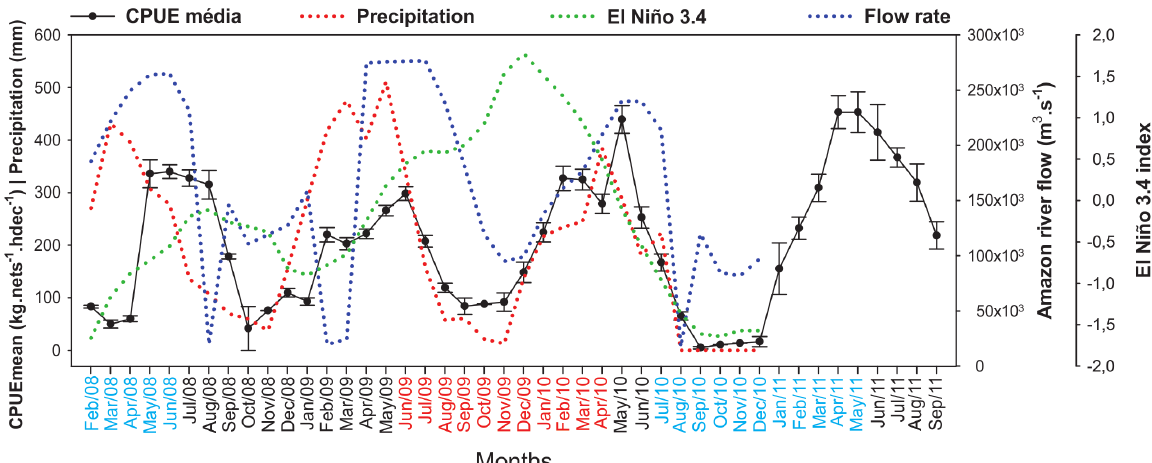
Figure 4. Variation 1 CPUE average per month B. vaillantii , El Nino index variation 3.4 along the time series and the variation of the average rainfall and the Amazon river flow along the time series. Months in blue = La Niña event; months in black = neutral; months in red = El Niño